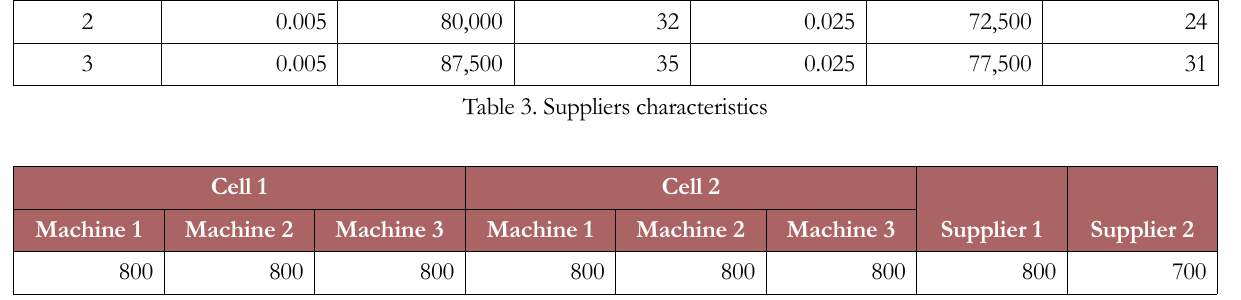
Table 4. Machine and supplier